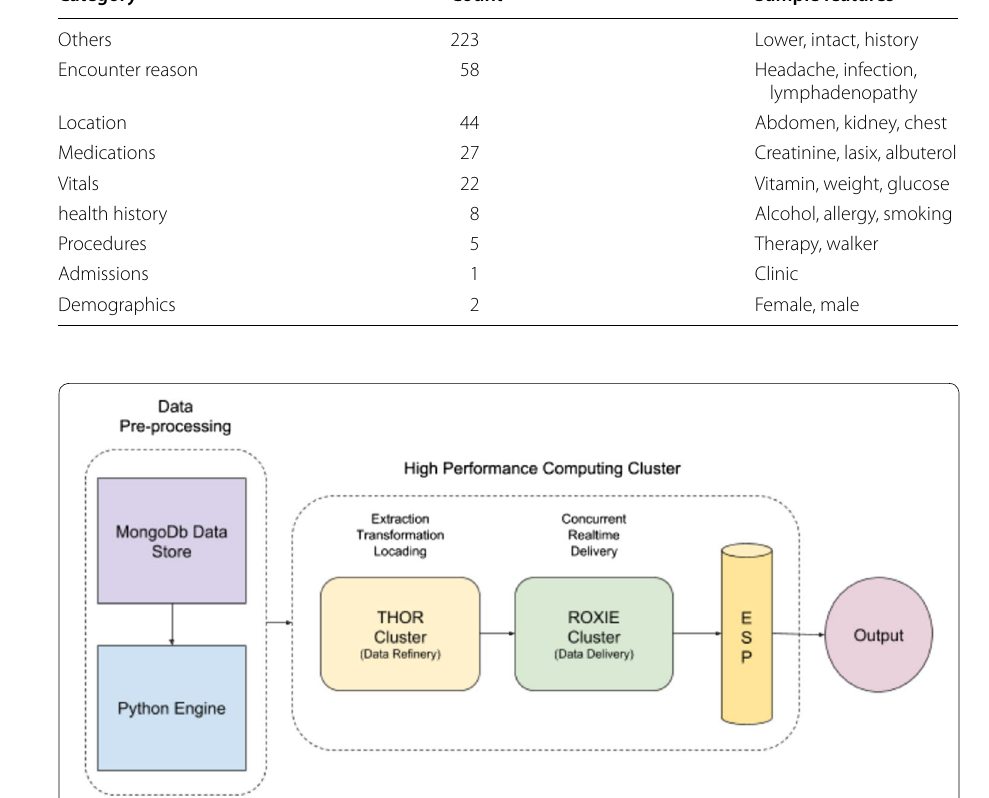
Table 1 Summary of extracted features and sample features per category Category Count Sample features